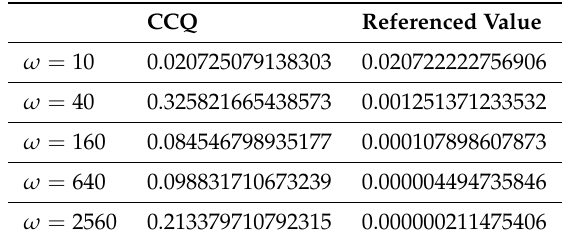
Table 1. Numerical results of classical delaminating quadrature rules for highly oscillatory